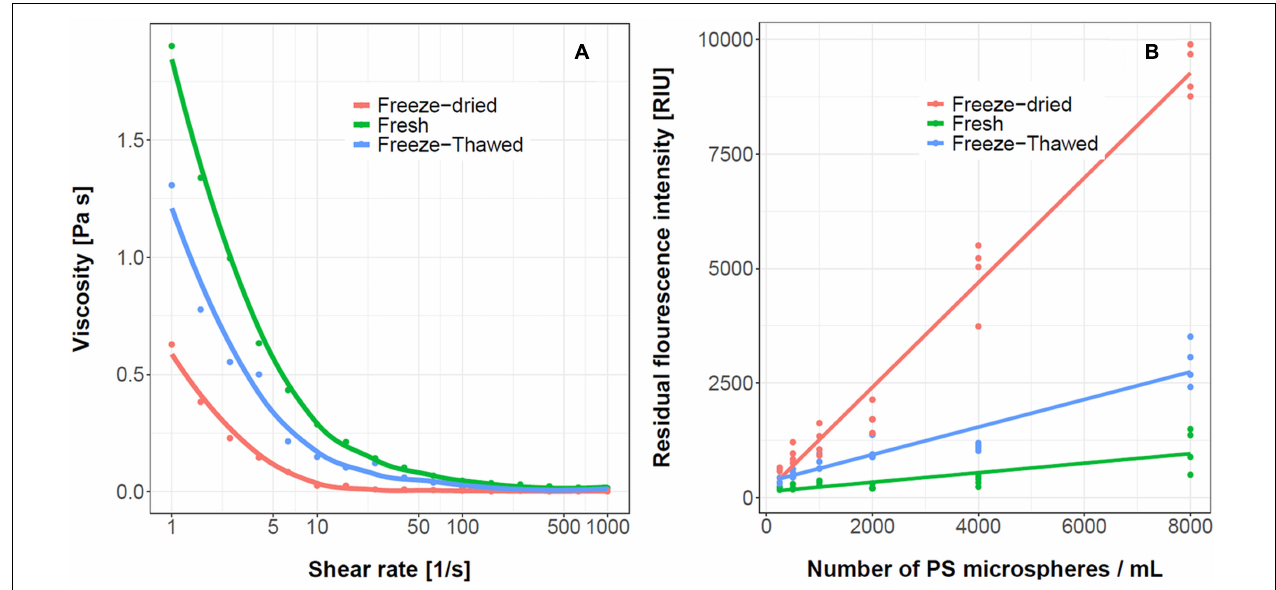
FIGURE 10 | The effect of R. pulmo mucus processing on viscosity and ability to sequester PS microspheres. The viscosity curves (A) and the residual fluorescence intensity in the water after addition of mucus (B) , n = 4. The concentration of mucus was 3% (w/v). The samples were prepared either freshly, after freeze/thaw, and freeze/dry